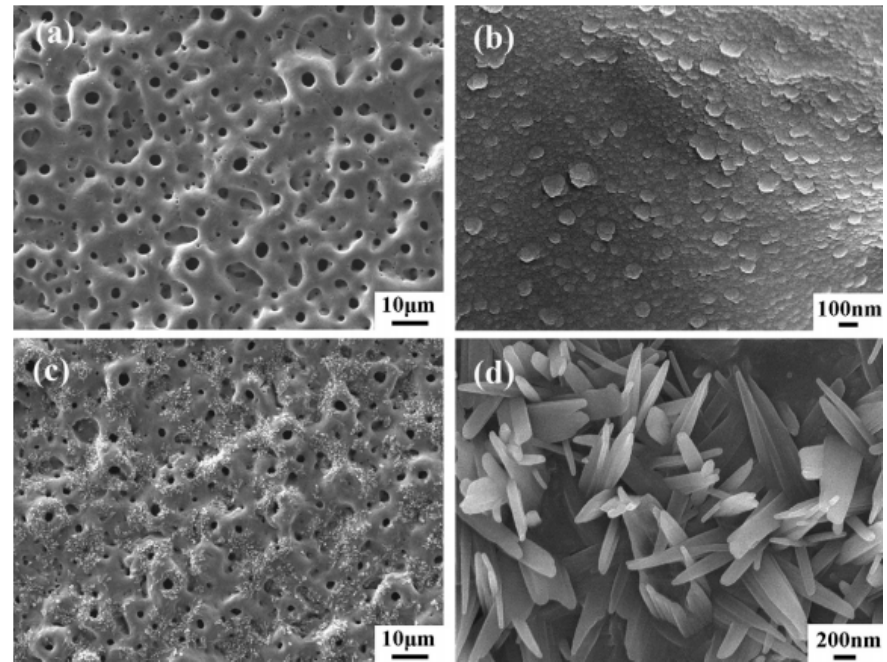
Figure 4. Surface morphologies of the TiO 2 ( a , b ) and TiO 2 /CaSiO 3 ( c , d ) coatings in different magnifications [37]. Reprinted with permission from reference [37] 2013 Elsevier.